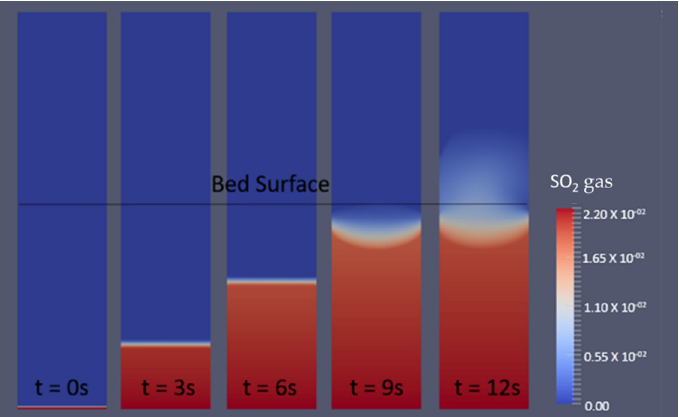
Figure 6. Schematic of initial setup for pilot scale simulation. The gray shaded area represents the region in which sorbent particles are originally placed.